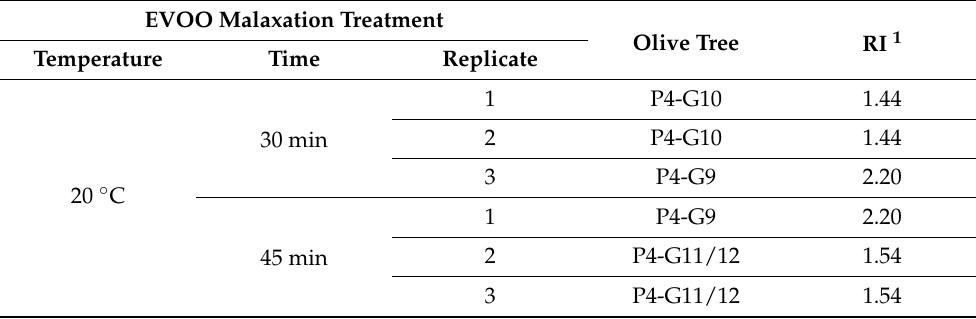
Table A1. The correspondence between the olive tree and the RI for each EVOO